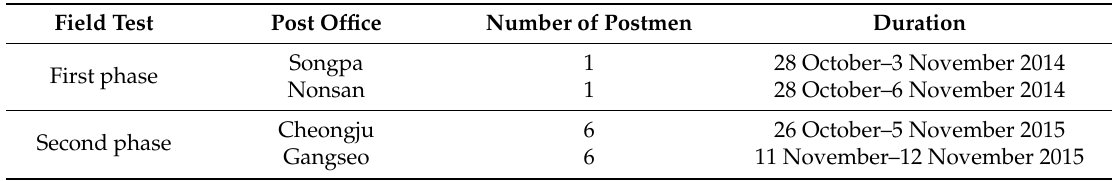
Table 9. Settings of two-phase of field